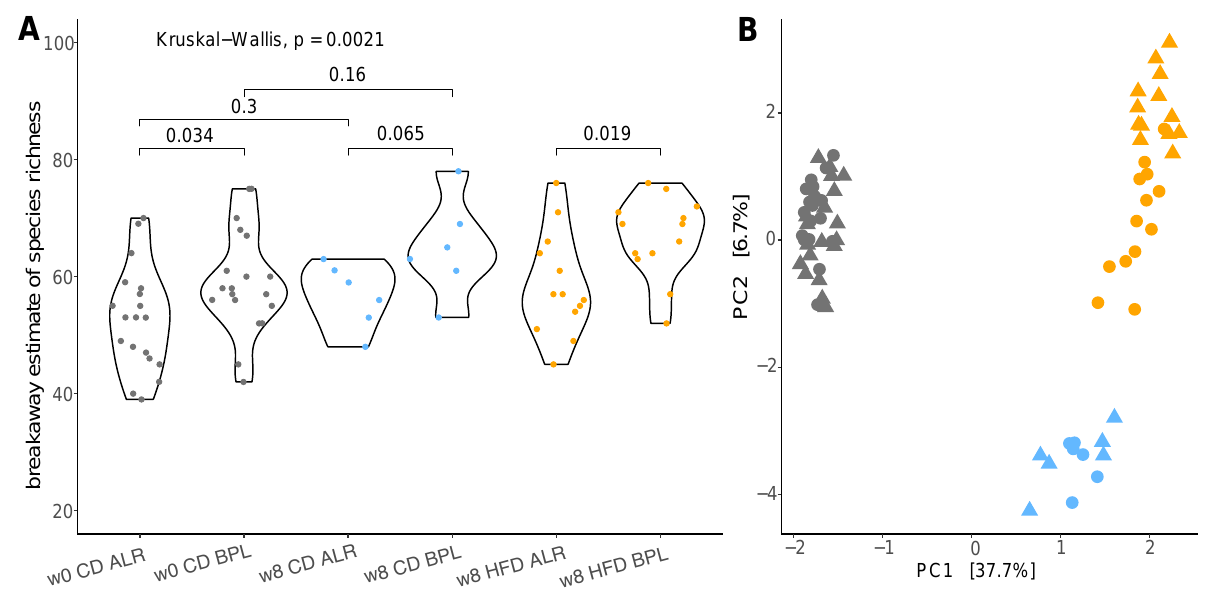
Figure 1. Alpha diversity and beta diversity of gut microbiota in B6-mt BPL and B6-mt ALR mice. ( A ) Alpha diversity plot depicting the breakaway estimate of species richness. Dots denote individual estimates of species richness and violins show the distribution of the data. ( B ) Redundancy analysis plot of beta diversity showing Aitchison distances to assess differences in community composition. Grey refers to mice at week 0 (w0), blue to control diet fed (CD) mice at week 8 (w8) and orange to mice on high-fat diet (HFD), respectively. B6-mt ALR mice are shown in dots and B6-mt BPL mice are shown in triangles. First principal coordinate (PC1) explains 37.7% of the total variation observed, PC2 explains an additional 6.7%.